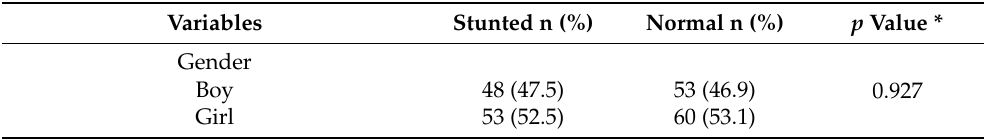
Table 3. Socio-demographic and hygiene practice characteristics of stunted and normal children aged 36–45 months in East Nusa Tenggara Timur,